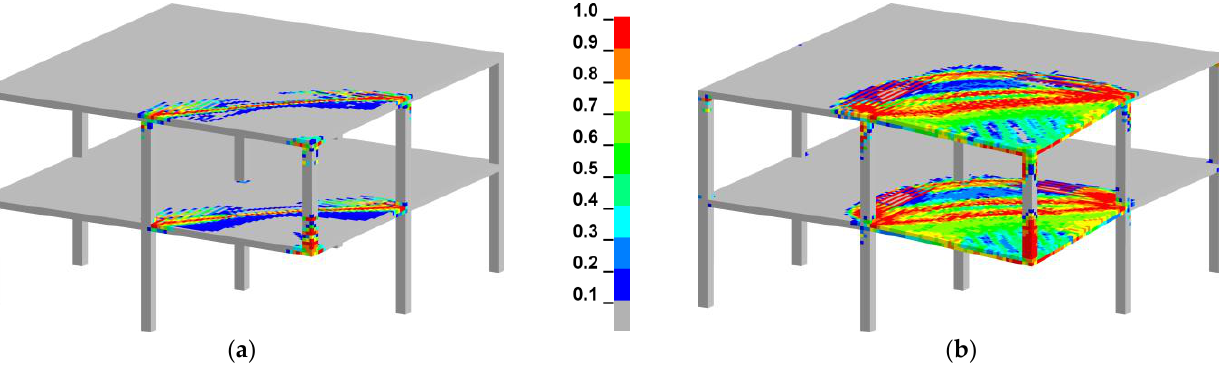
Figure 9. Damage of the two-story RC frame from nonlinear static analysis at different load levels: ( a ) — 0.6·P max ; ( b ) — 1.0·P max .